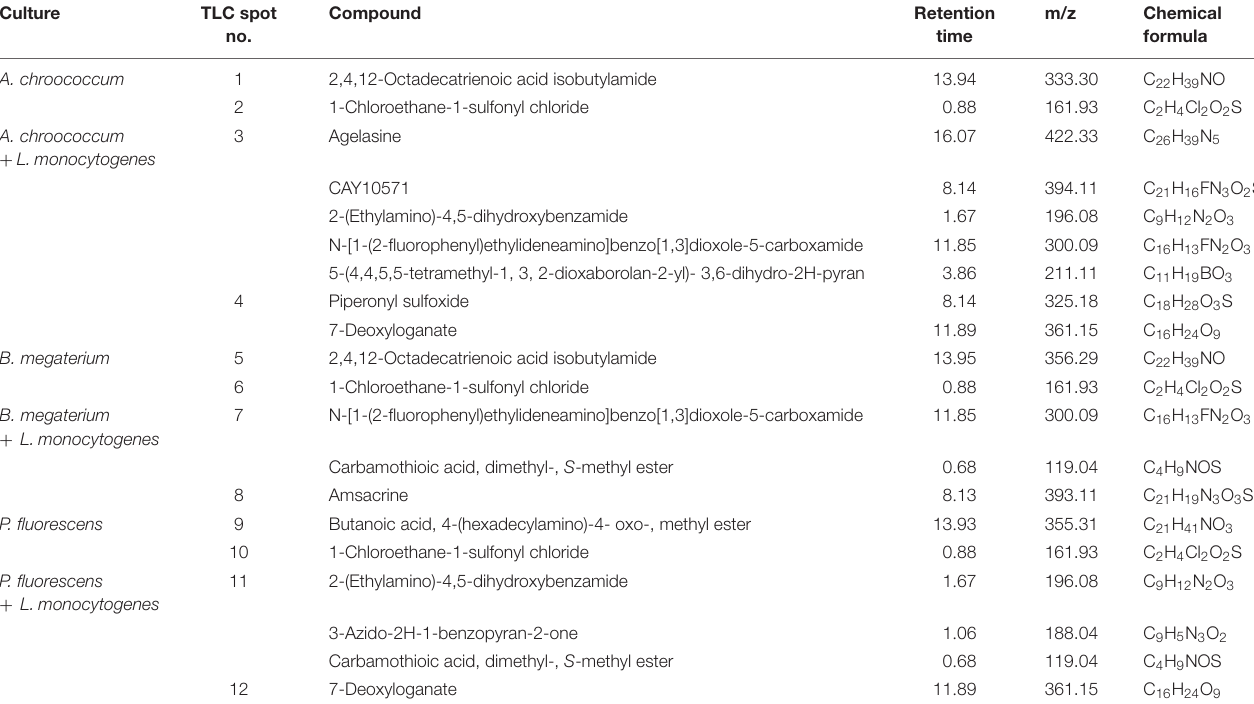
TABLE 1 | Major non-volatile compounds released by Azotobacter chroococcum , Bacillus megaterium , and Pseudomonas fluorescens in pure cultures, and during co-cultivation with Listeria monocytogenes . Culture TLC spot